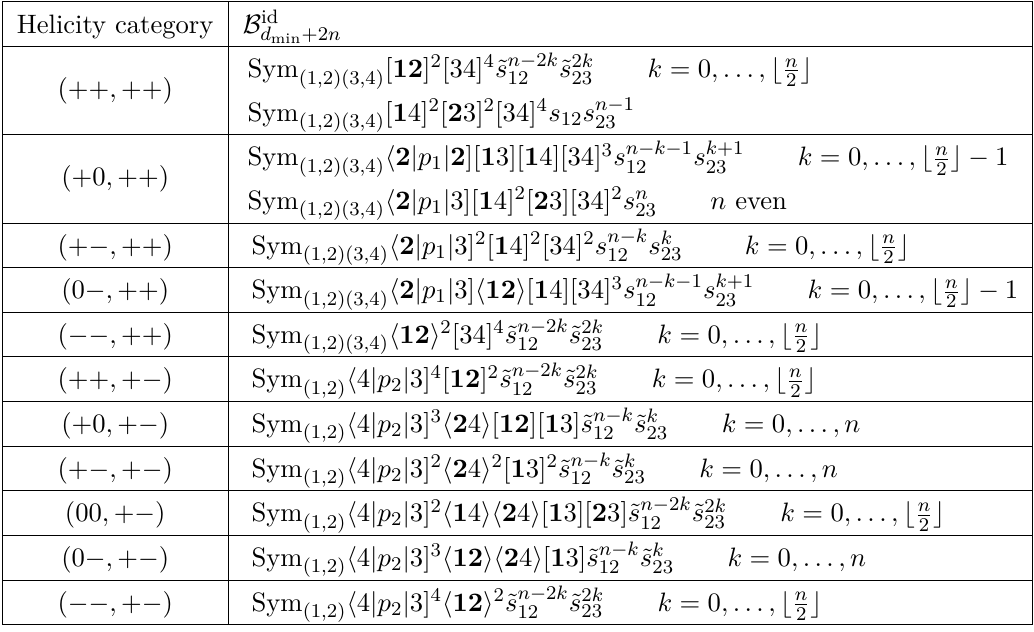
Table 2 . The amplitude bases for the different helicity categories, after taking into account that we are dealing with identical bosons. On the right-hand side, we wrote only the transversality and the helicity of each particle, separating massive and massless states with a